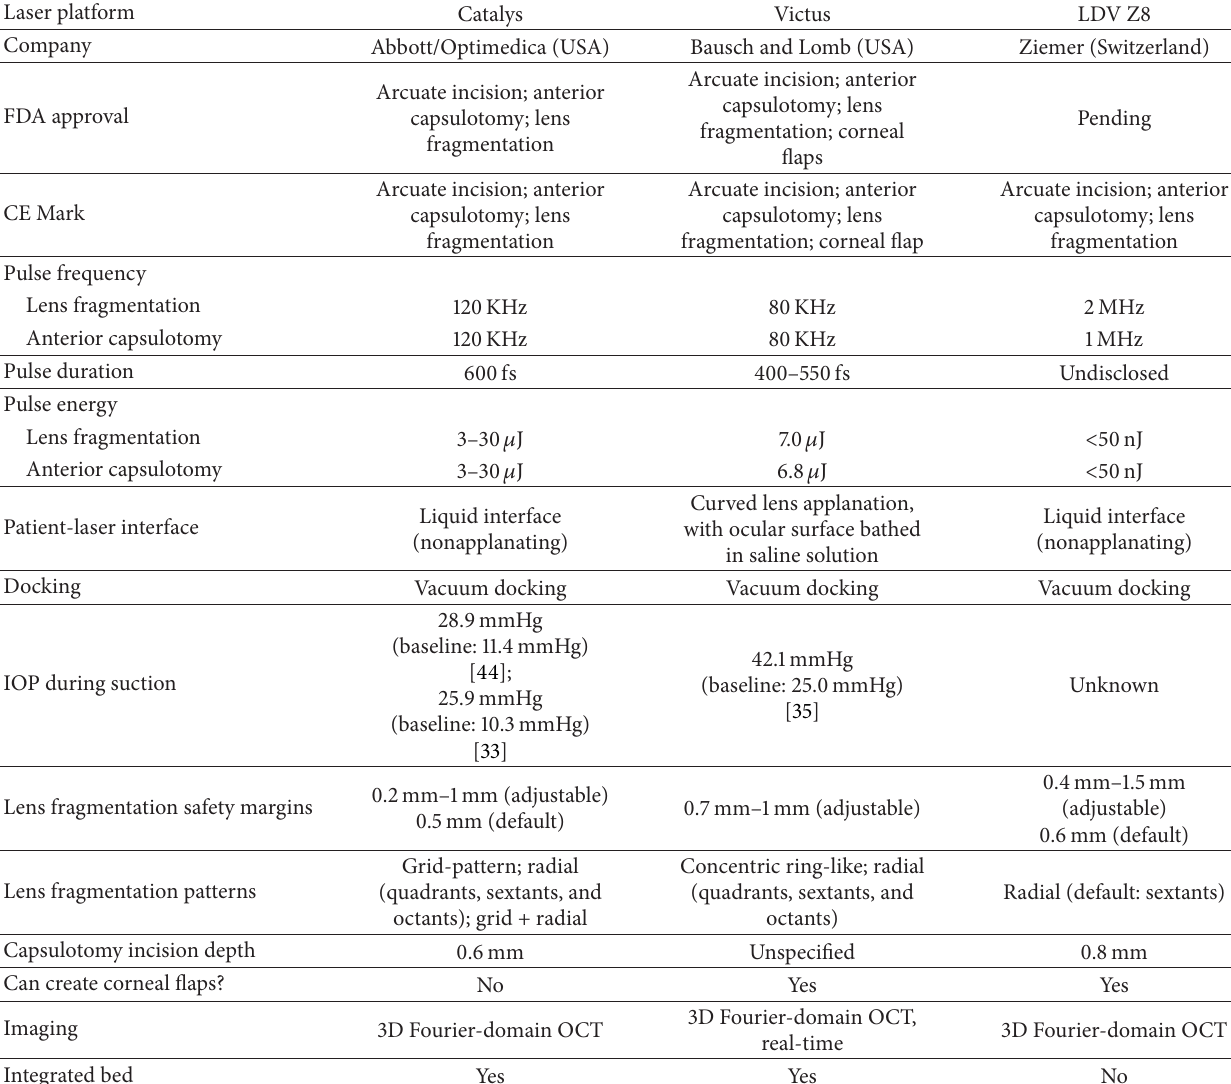
Table 1: Feature comparison across three femtosecond laser